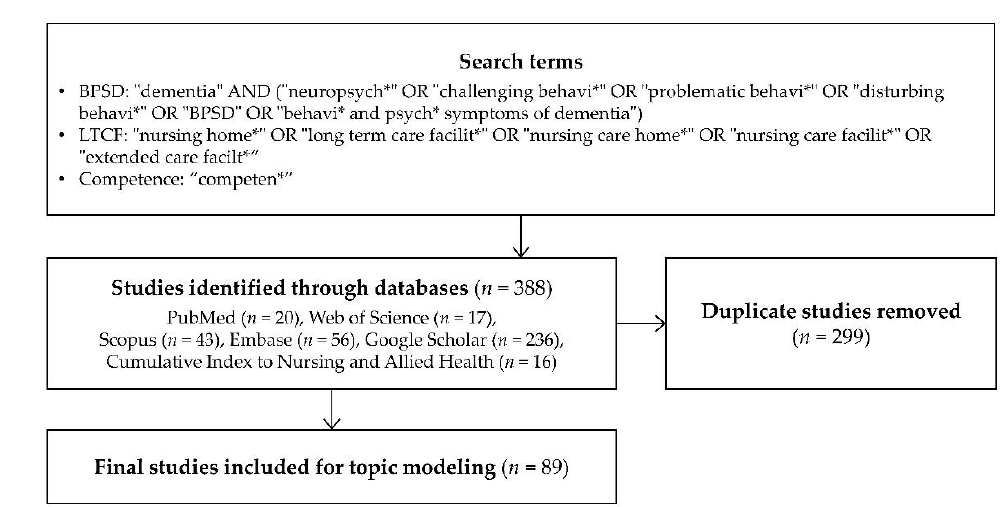
Figure 2. Process of data collection for the topic modeling.